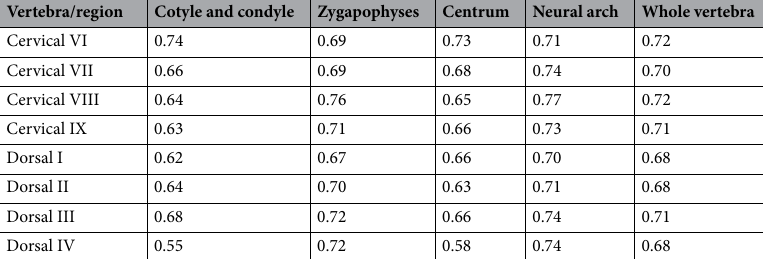
Table 2. Mean ASP values of selected regions of the vertebrae of SNSB/BSPG 1991 I 27.